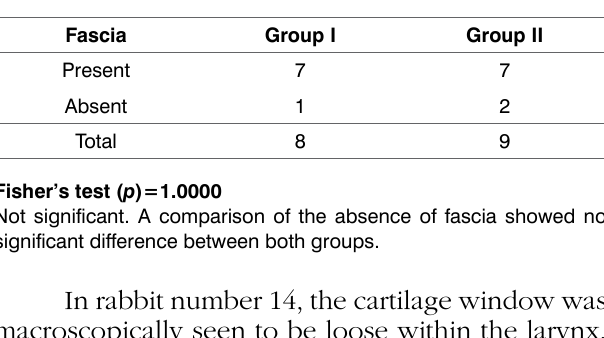
Table 1. Number of animals according to the presence or absence of fascia in the histological analysis of both